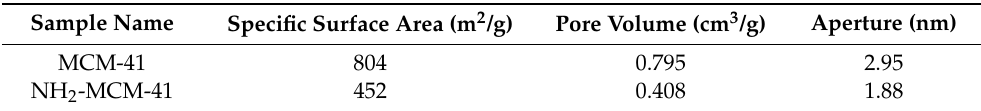
Figure 6. N 2 adsorption–desorption isotherms ( A ) and pore size distribution ( B ) of MCM-41 and NH 2 -MCM-41. Table 1. The pore structural parameters of MCM-41 and NH 2 -MCM-41.